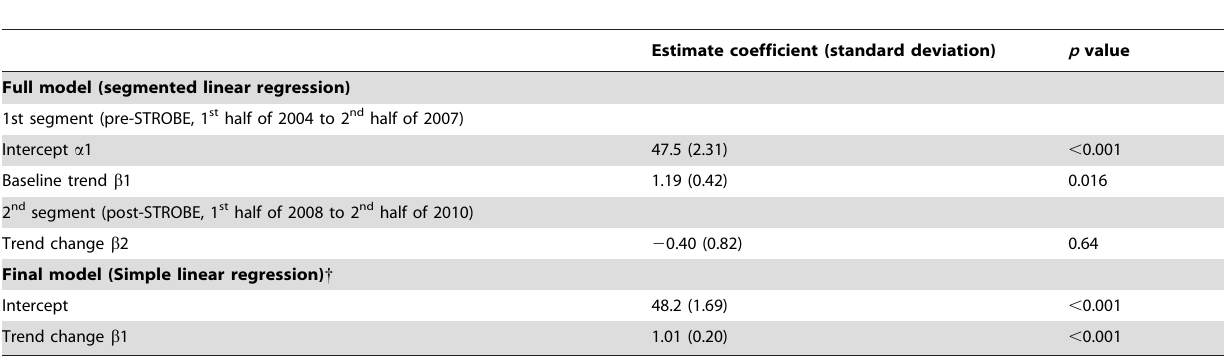
Table 3. Parameter estimates from the full and most parsimonious final linear regression models predicting the mean six-monthly STROBE score per